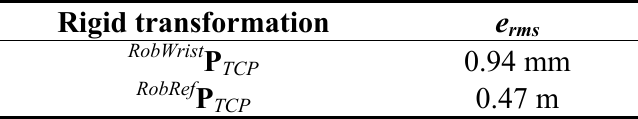
Table 1. Pivot residual error (n =